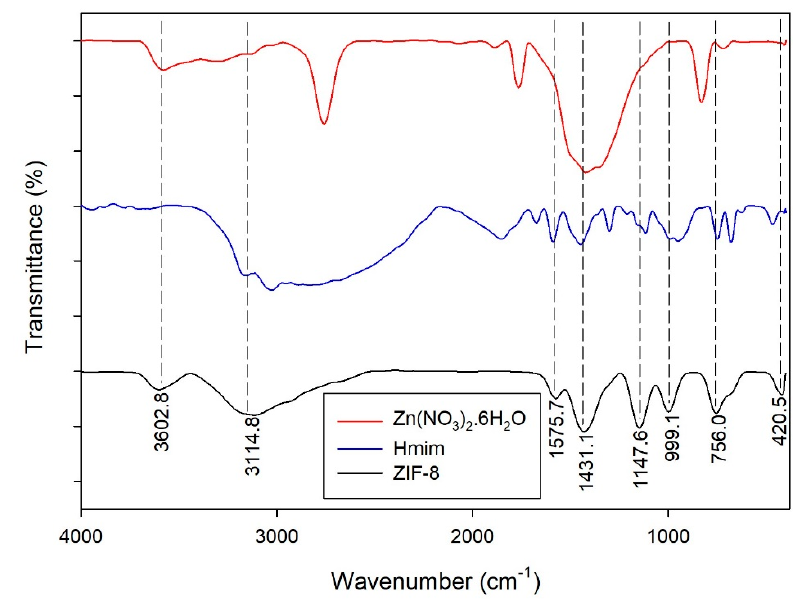
Figure 9. FTIR spectra of Zn(NO 3 ) 2 .6H 2 O, Hmim and ZIF-L.